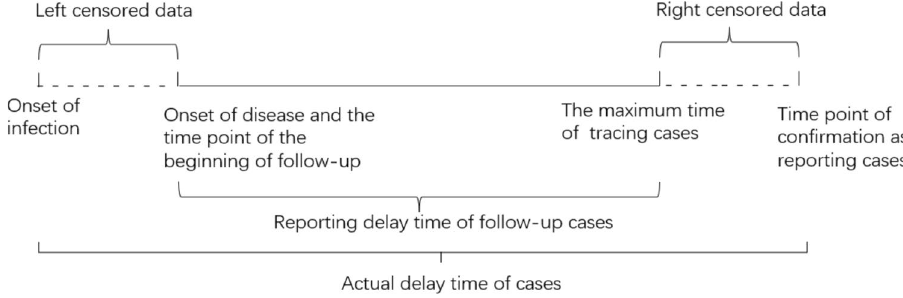
Figure 2. Reporting delay time of cases.